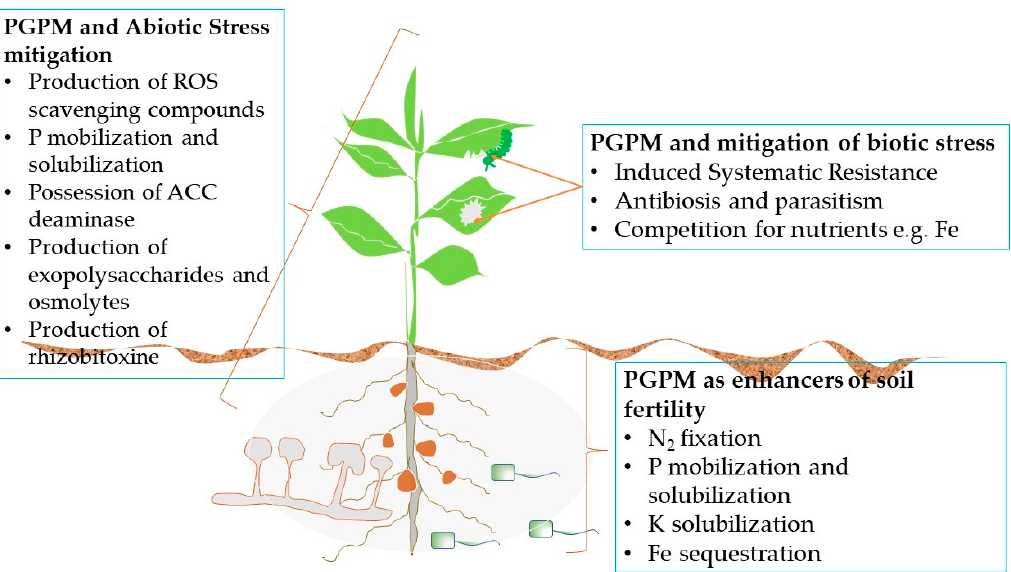
Figure 1. Mechanisms employed by plant growth promoting microorganisms (PGPM) to mitigate e ff ects of biotic and abiotic stress on plants.